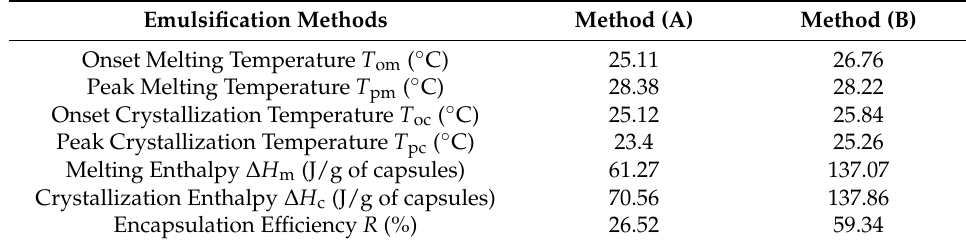
Table 3. Thermal properties of M-NEPCMs prepared with different emulsification